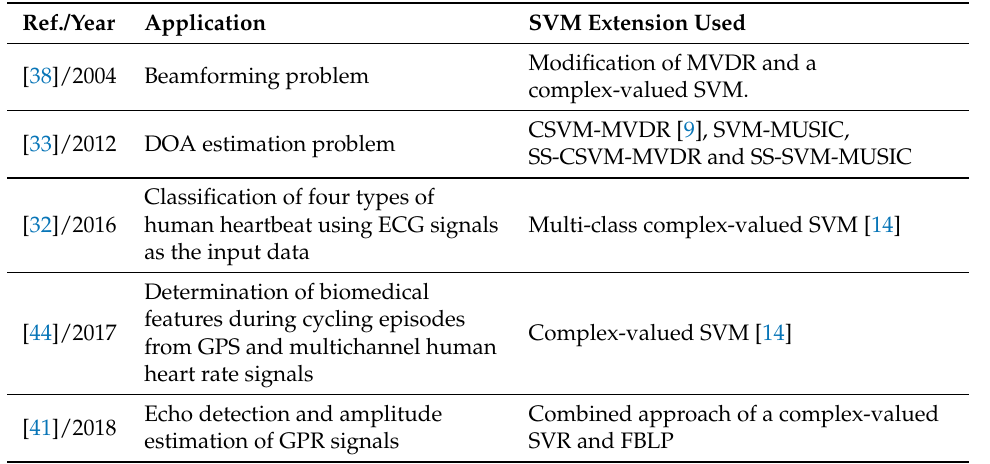
Table 2. Applications of complex and hypercomplex SVMs for solving signal processing